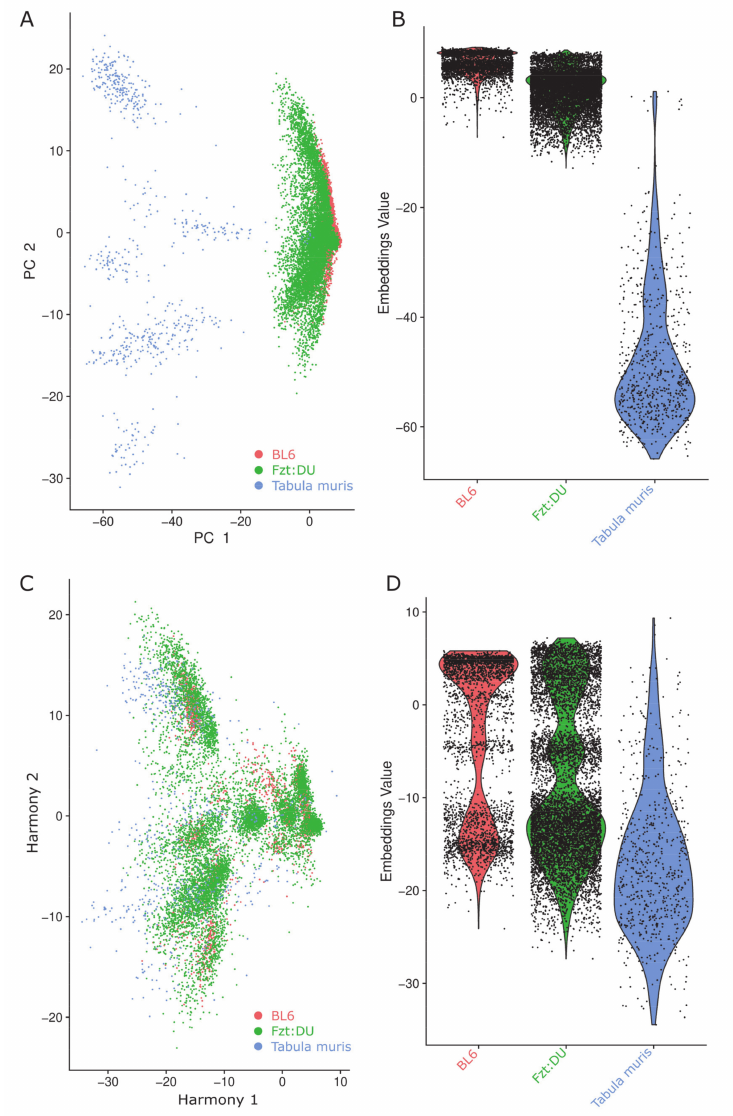
Figure 1. Clustering e ff ects of the data integration with and without utilizing Harmony on the embedding in the first two principal components (PC) on the indicated datasets (BL6, red; Fzt:DU, green; Tabula muris, blue). ( A ) PCA-plot of the three investigated datasets without Harmony processing. ( B ) Violin plot of the investigated datasets without Harmony processing. ( C ) PCA-plot of the three investigated datasets with Harmony processing. ( D ) Violin plot of the three investigated datasets with Harmony